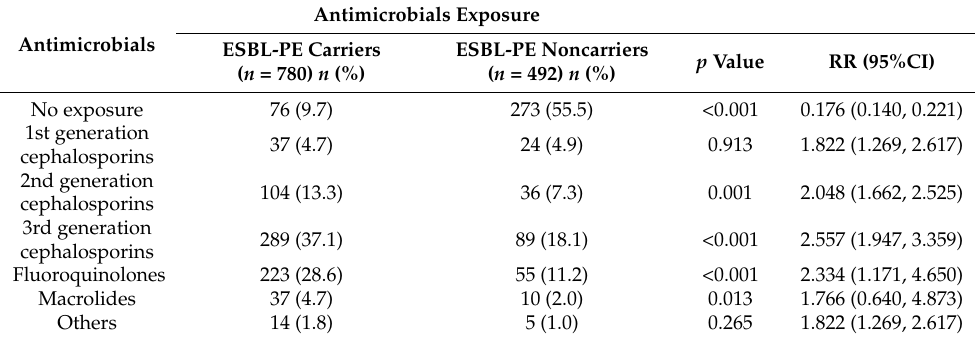
Table 5. Correlation between intestinal ESBL-PE carriage and antimicrobial exposure during the 9 months prior to sample